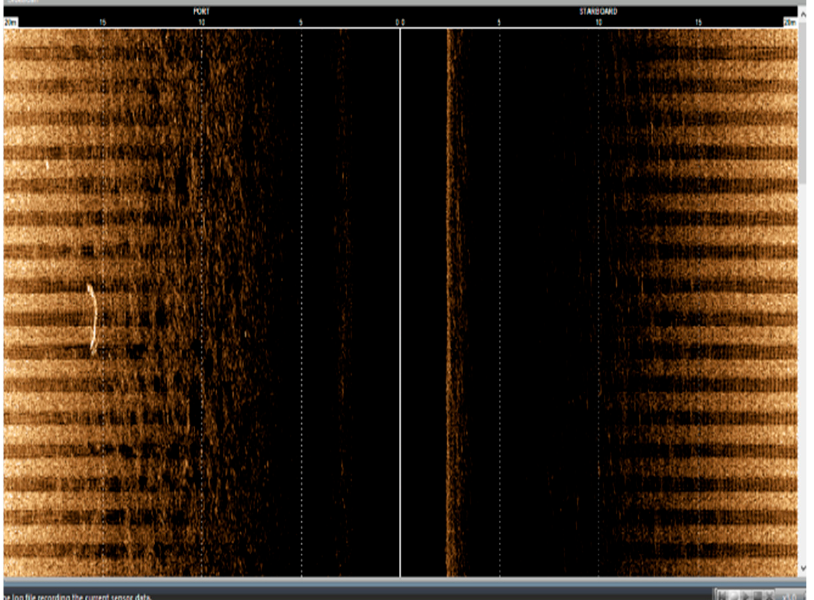
Figure 12. Sonar image with cumulative effort applied to the WAM-V with cables routed closely. (The object on the left is the same object as the object on the left seen in Figure 13.)